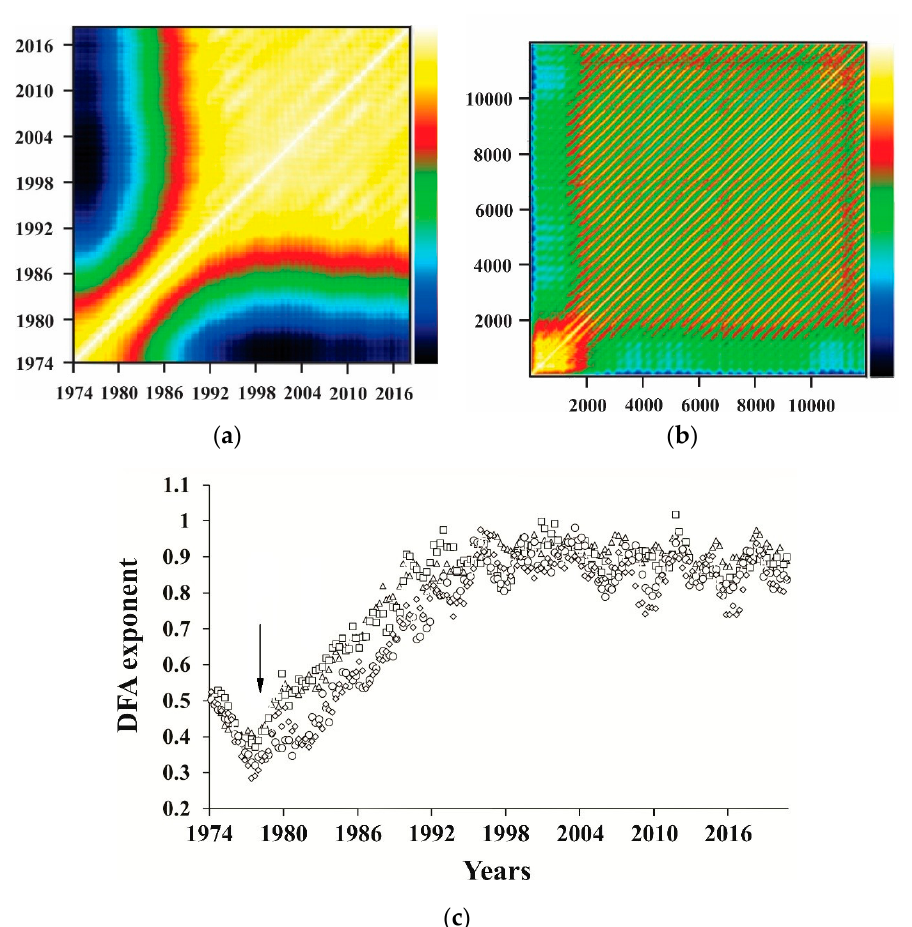
Figure 6. Recurrence plots of waiting times of EQs in local seismicity from March 1974 to March 2017 for R = 50 km ( a ) and water level in the Enguri dam reservoir from April 1978 to August 2017 ( b ), where on the axes are day marks after the start of recharge. The blue cells correspond to less recurrence and yellow ones to better recurrence of events; ( c ) the DFA analysis reveals beginning of ordering in seismic events after 1980 and strong recurrence regime after 1986.